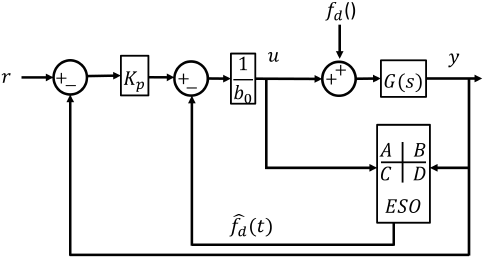
Figure 7. Linear Active Disturbance Rejection Control ( LADRC )